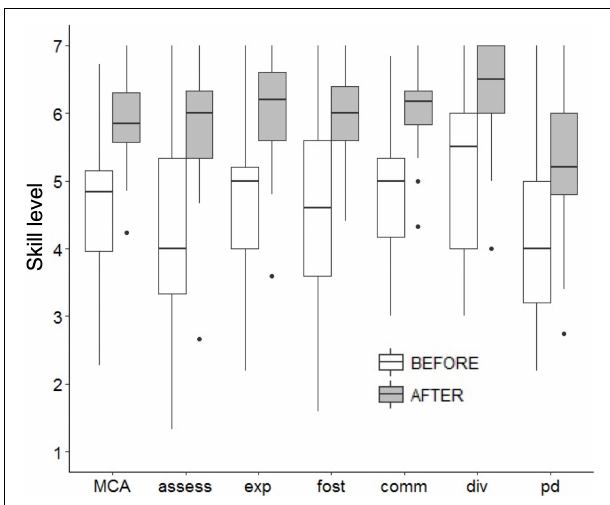
FIGURE 2 | Changes in mean mentor Mentoring Competency Assessment composite scores (MCA) and subscales from self-reported retrospective pretest. A 7-point Likert-type scale (1 = “not at all skilled,” 4 = “moderately skilled,” 7 = “extremely skilled”) was used. Change for MCA and all subscales was statistically significant ( P < 0.001). X-axis labels as follows: assess, assessing understanding; exp, aligning expectations; fost, fostering independence; comm, maintaining effective communication; div, addressing diversity; pd, promoting professional